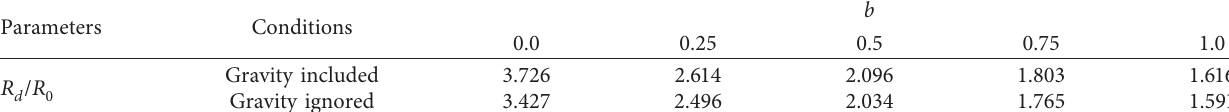
Table 4: Damage zone radius of the tunnel under various gravity